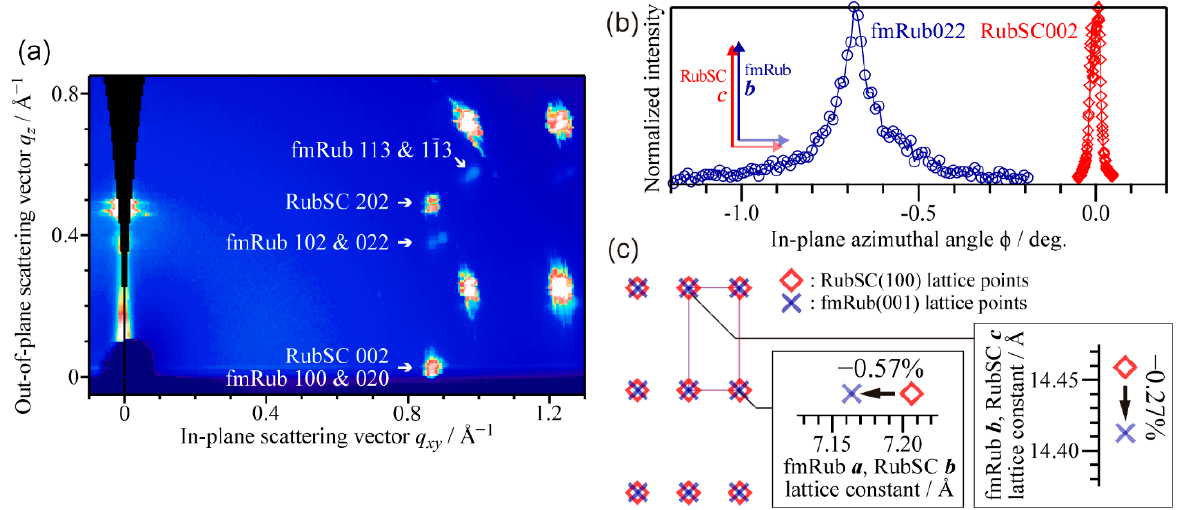
Figure 14. ( a ) Azimuthally integrated 2D-GIXD image of a RubSC sample covered with 50 nm-thick fmRub. ( b ) Azimuthal profiles of the RubSC002 (red) and fmRub022 (blue) diffraction spots. ( c ) Inter-lattice relationship between quasi-homoepitaxial fmRub and the RubSC (100) surface. Cited from [39] (CC-BY).